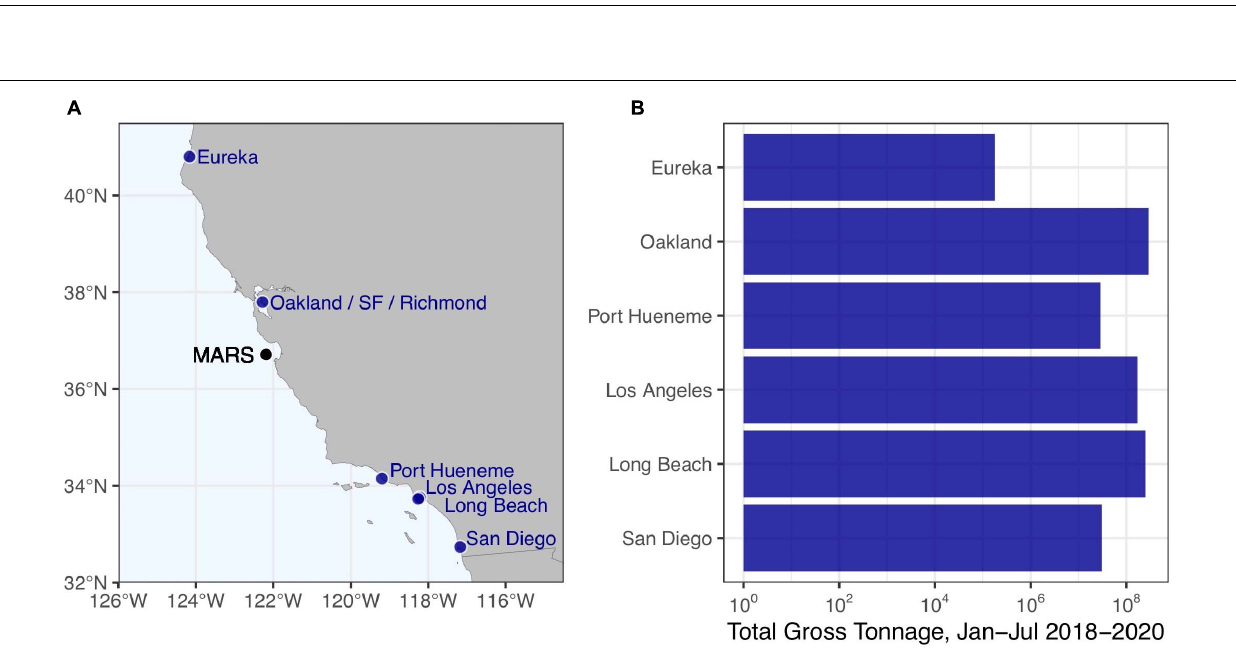
FIGURE 7 | Statewide port activity. (A) Locations of California ports relative to MARS, and (B) total gross tonnage for January through July, 2018 through 2020, the time period for which acoustic data were analyzed ( Figure 6 ). Records for the ports of San Francisco and Richmond are grouped with Oakland; Los Angeles and Long Beach port entry locations nearly